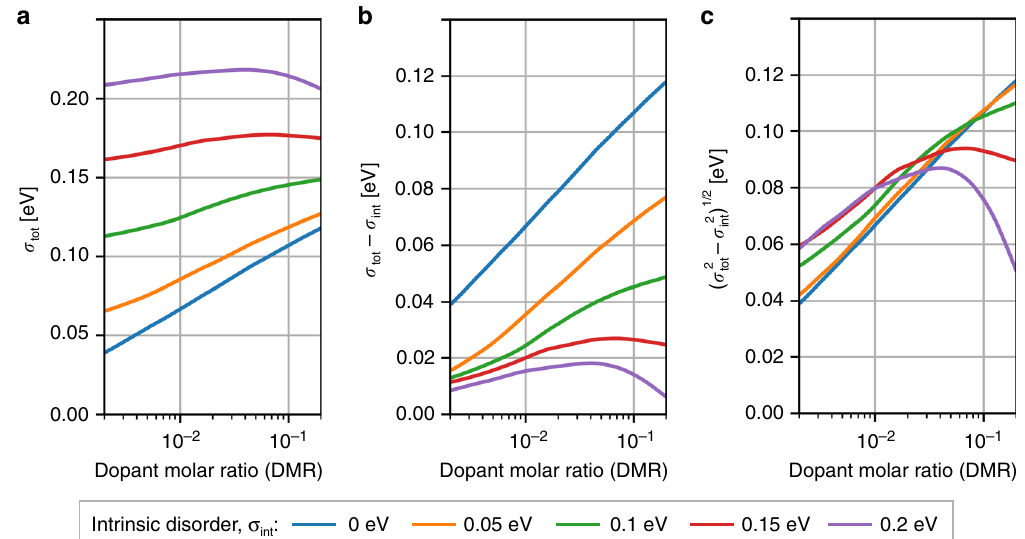
Fig. 5 Correlation of the intrinsic and doping-induced disorder. a Standard deviation of the HOMO distribution (total disorder) σ tot of the of host molecules in the doped material as a function of the dopant molar ratio (DMR) for materials with a various intrinsic disorder, σ int . b Excess disorder due to doping, σ tot − σ int . c Extrinsic disorder if intrinsic and extrinsic disorder would be not correlated, ( materials with stronger intrinsic disorder ( a ), excess disorder due to doping de fi ned as σ tot − σ int shows an opposite trend: the larger the intrinsic disorder is, the smaller is the excess disorder ( b ). Moreover, the excess disorder may even decrease upon doping of materials with large σ int . We refer to this effect as the disorder compensation. Panel c shows that the doping-induced and intrinsic disorder sources are not fully uncorrelated, otherwise all lines